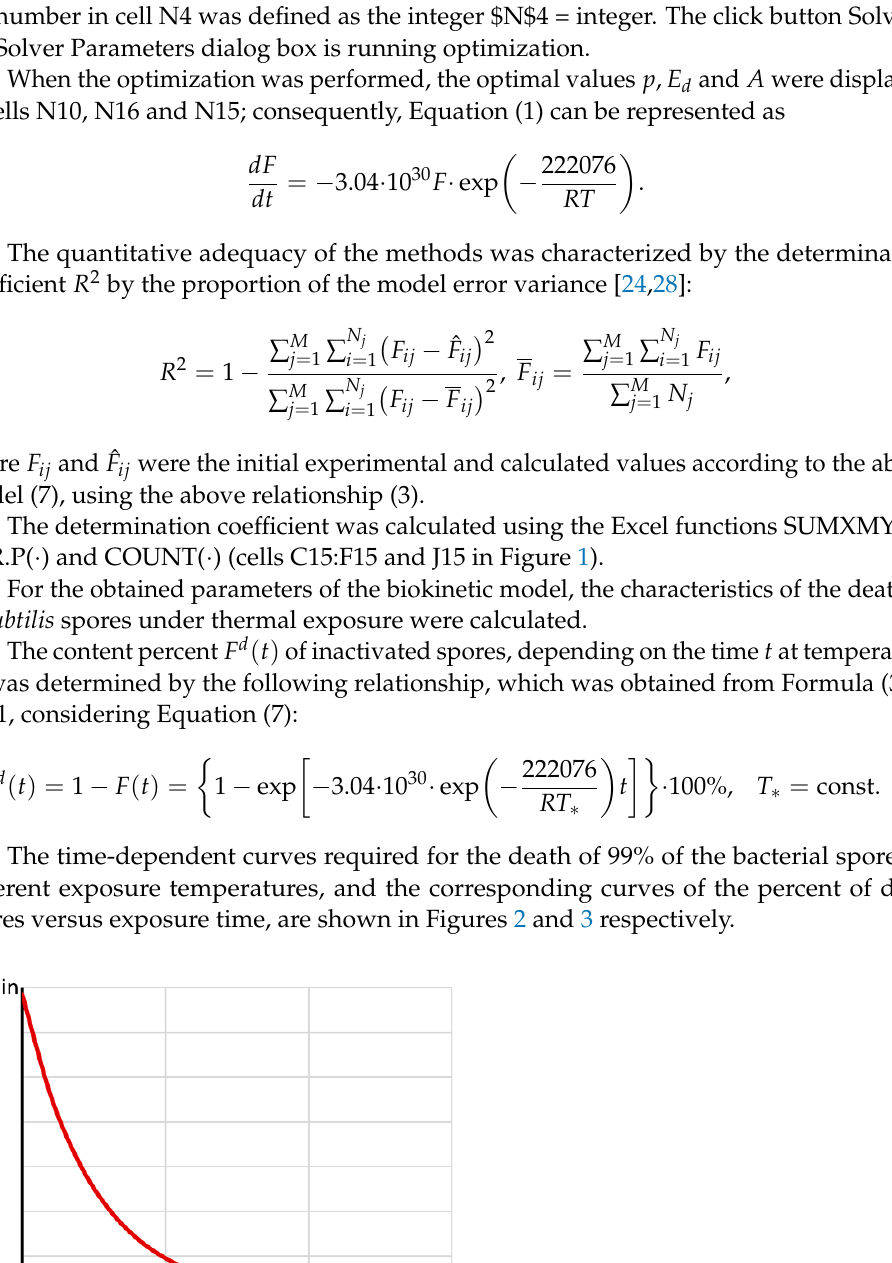
Figure 3. The percent change of dead bacterial spores versus time at different temperatures. The curves were essentially exponential; a small increase of tem perature had a significant effect on the death of spores. The comparison of the time required to kill 99% of the spores, between the calculated value according to Equation (3) and the given value [10], was less than 4.9%. The calculated value of the inactivation energy 𝐸𝐸 𝑑𝑑 = 222076 J ⋅ mol −1 differed from the given value [10] by 1.2%. For mathematical models that include the temperature Arrhenius function, analysis of linear correlation between the results of the direct problem solving and experimental data is a powerful tool for examining these models [1,29]. The results obtained at certain values of the kinetic parameters of the Arrhenius function must always be compared with the original experimental data to confirm the actual application based on the accepted assumptions. When the proposed approach was used, the attained value 𝑅𝑅 2 > 0.999 indicated the quantitative adequacy, and the high level of the approximation accuracy for the identification of the kinetic parameters of the model. To analyze the mortality level of the micro-organisms, the parameter 𝐷𝐷 —the tenfold decrease time (or decimal reduction time) in number for certain values at constant temperatures of the content of a bacterial culture was used [15,19,23,30]. To approbate the proposed approach, a second example relating to the identification of kinetic parameters for 𝐷𝐷 -type experimental data could be used in the following form: 𝐷𝐷 ( 𝑇𝑇 ) = ln(10) exp( 𝐸𝐸 𝑑𝑑 𝑅𝑅𝑇𝑇⁄ ) 𝐴𝐴⁄ , [ 𝐷𝐷 ] = 𝑠𝑠 , (10) which was derived from Equation (3) at 𝑝𝑝 = 1 and 𝑑𝑑 = 0.9. The identification of the kinetic parameters 𝐸𝐸 𝑑𝑑 and 𝐴𝐴 of model (1) or Equation (10) was considered by the example of the data of spore mortality B. anthracis in liquid media [30]. The experimental temperatures and the corresponding 𝐷𝐷 values for 𝑁𝑁 = 8 data pairs